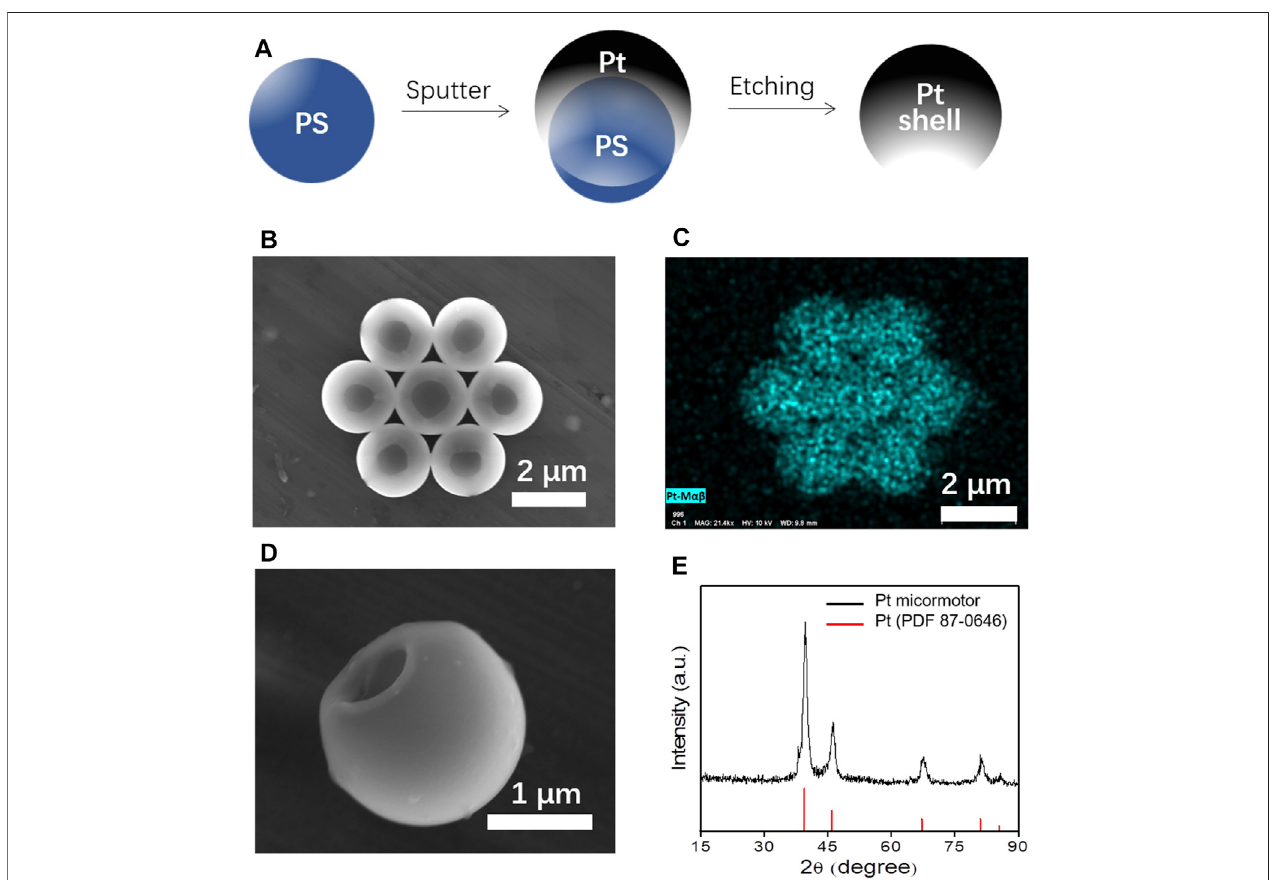
FIGURE 2 | (A) Schematic of fabrication of Pt micromotor. (B,C) SEM of the Pt-based micromotors and the corresponding EDX results. (D) Magni fi ed single Pt micromotor. (E) XRD results of the